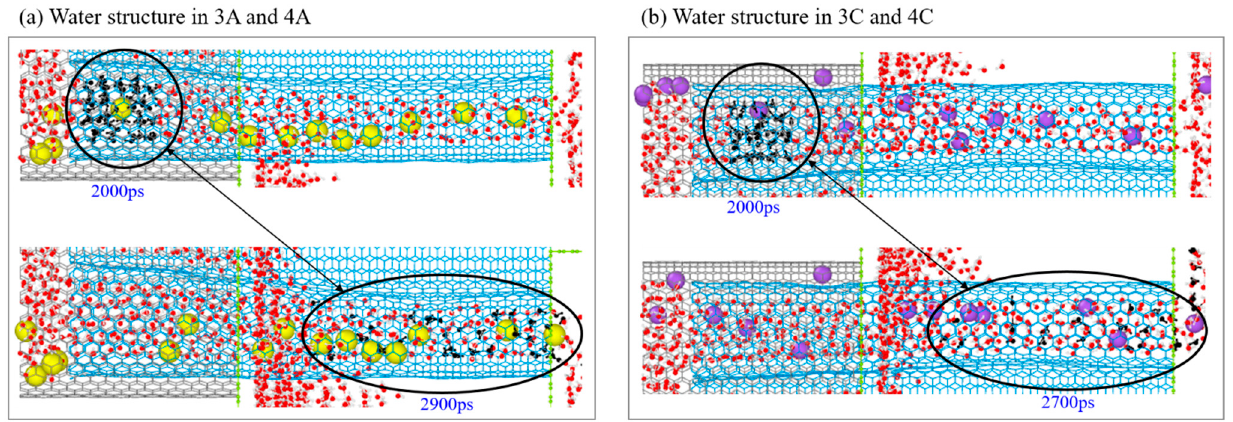
Figure 6. Deformation of water structure in the A-channel and C-channel. ( a ) In Ω 3A and Ω 4A ; ( b ) In Ω 3C and Ω 4C zones. The initial water cluster (black molecules) at the left end of Ω 3A/3C disperses before exit from Ω 4A or Ω 4C .